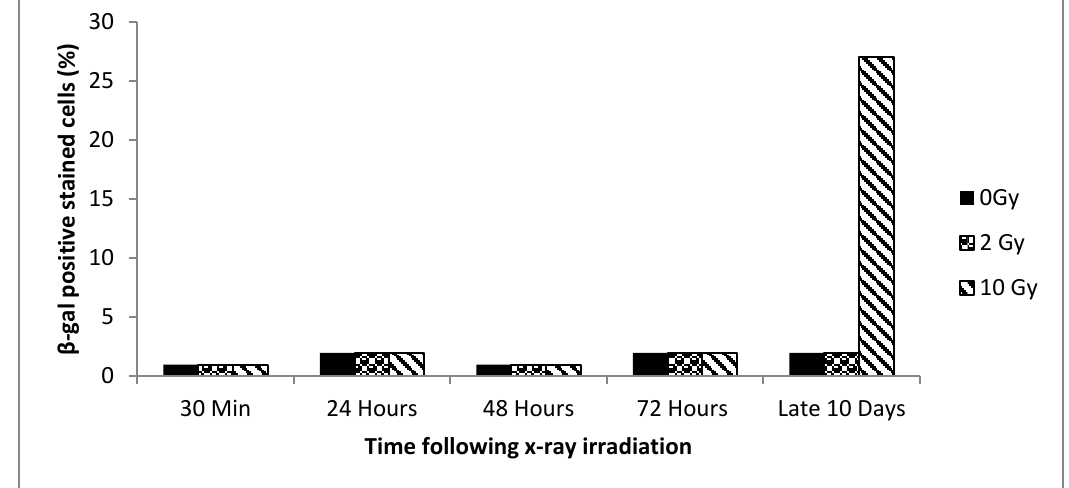
Figure 2. Results for younger cells. The percentage senescence at different time points (30 min, 24 h, 48 h, 72 h, and 10 days) after X-ray irradiation with 2 Gy or 10 Gy is shown. There is a significant difference in senescence in the 10 Gy samples between the 30 min sample and the 10 day sample (P value < 0.0001).